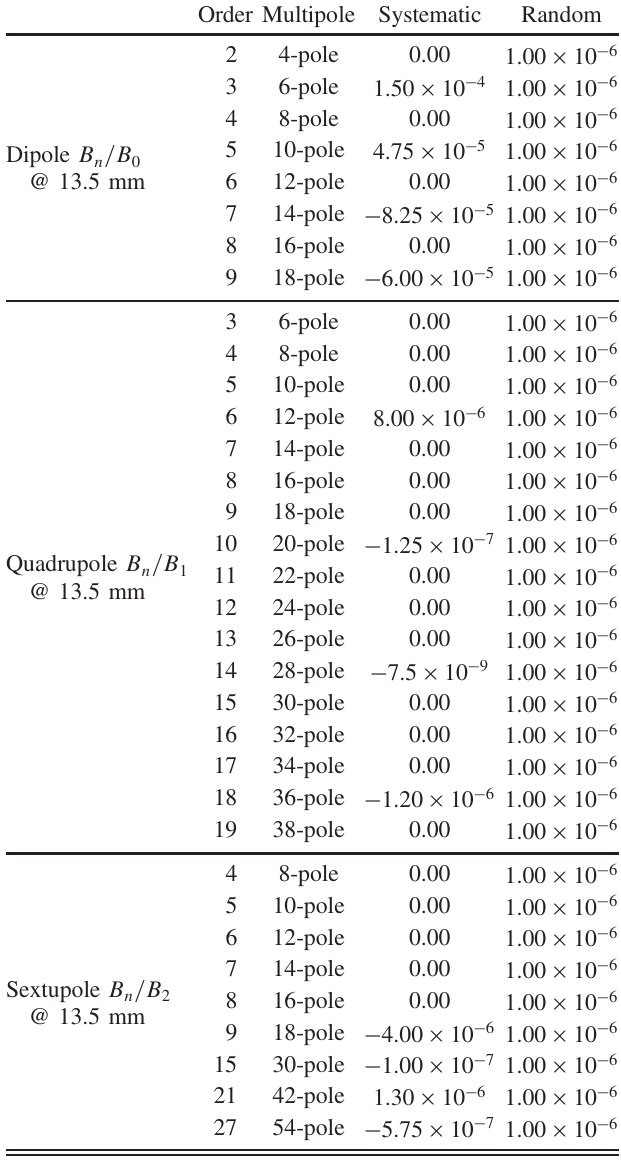
TABLE II. Systematic and random multipole components of the magnets [11]. The field expansion is assumed to be P ¼ ¼ x n − 1 = ð n − 1 Þ ! ð ∂ n − 1 B= ∂ x n − 1 Þ and n ¼ ∞ B B , where B y n n n ¼ 1 n is the order of the